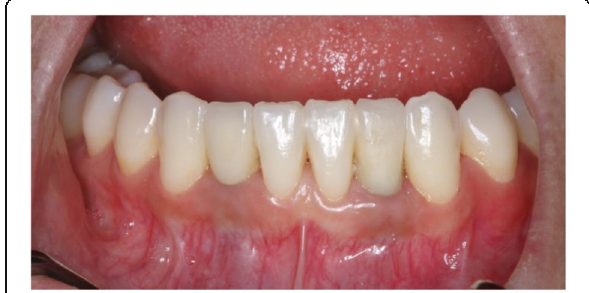
Fig. 6 Same patient after implant-prosthetic treatment with single crowns at clinical follow-up 1 year post-OP